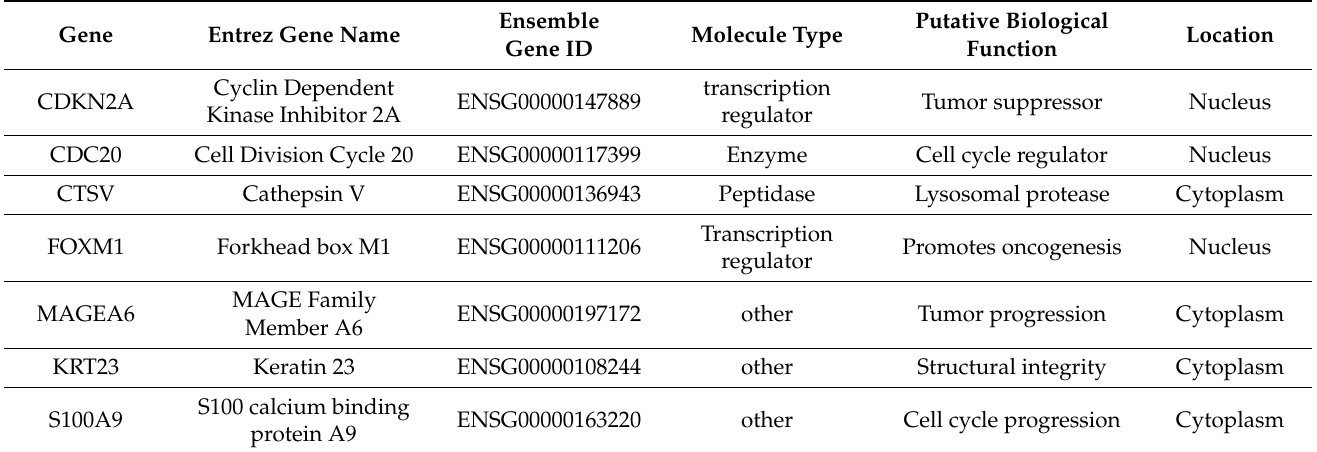
Table 2. Functional role and general information of the seven gene subset in bladder